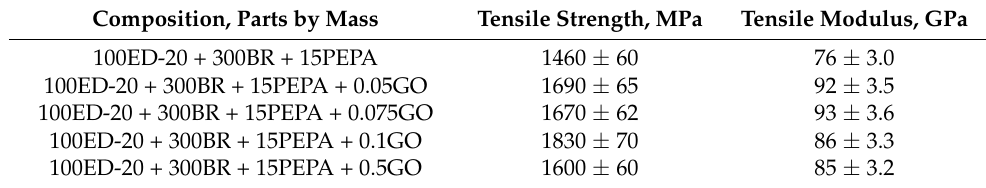
Table 1. Properties of reinforced epoxy composites. Composition, Parts by Mass Tensile Strength, MPa Tensile Modulus, GPa 100ED-20 + 300BR +